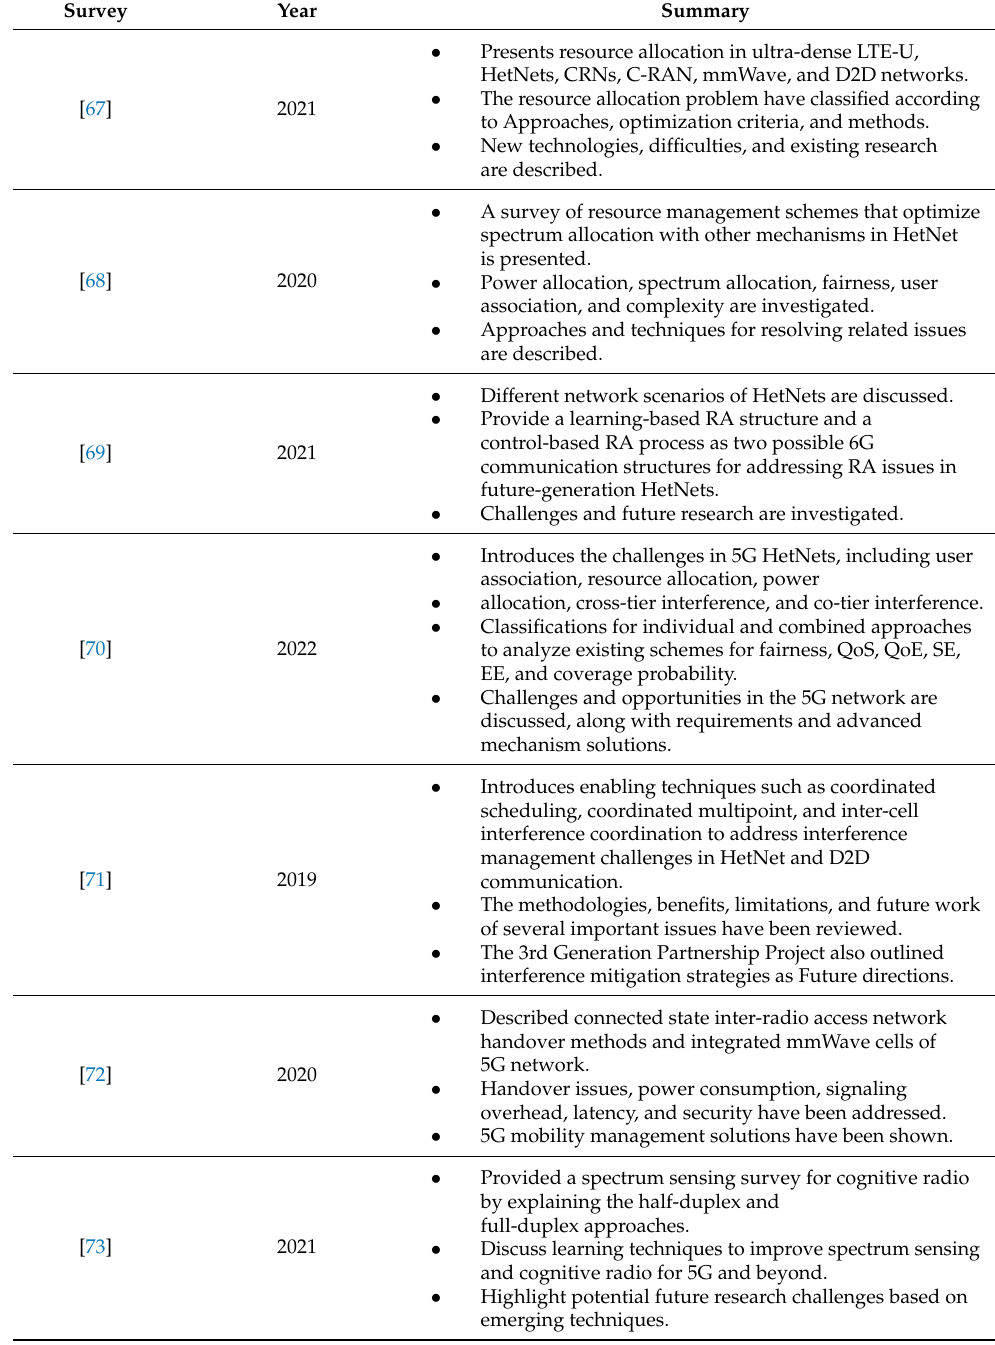
Table 1. Summary of the related work for resource